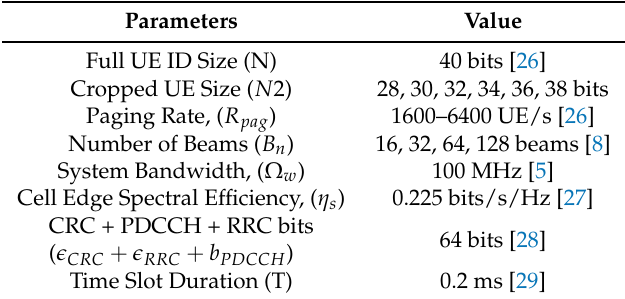
Table 3. Parameters for numerical analysis. CRC, Cyclic Redundancy Check; PDCCH, Physical Downlink common Control Channel; RRC, Radio Resource